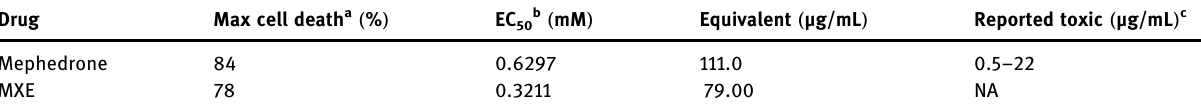
Table 1: MTT of selected NPS summary: mephedrone and MXE